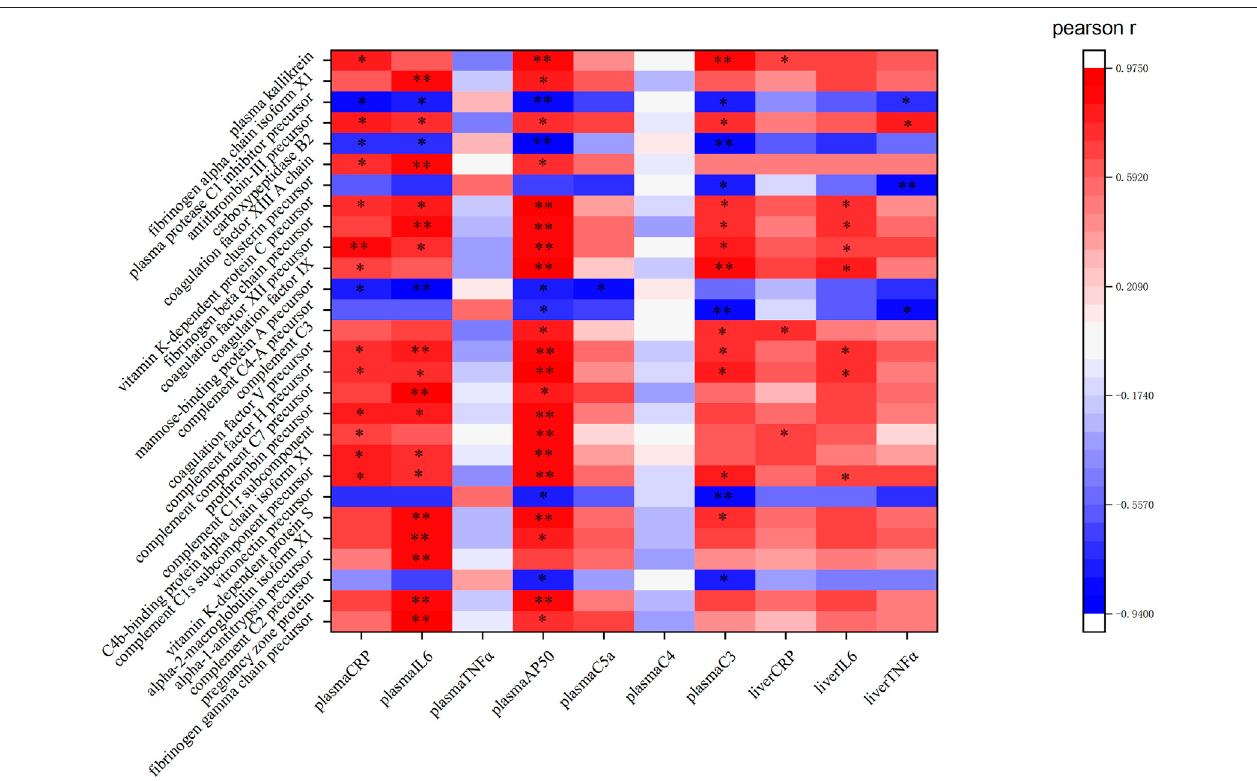
FIGURE10| Pearsoncorrelation analysisbetweentheproin fl ammatory cytokines, plasma complement factors, and theDEPsinthecomplementand coagulation cascade pathway: red represents a positive correlation, while green represents a negative correlation. ** and * in the fi gure mean the values of p < 0.01 and p < 0.05, respectively.